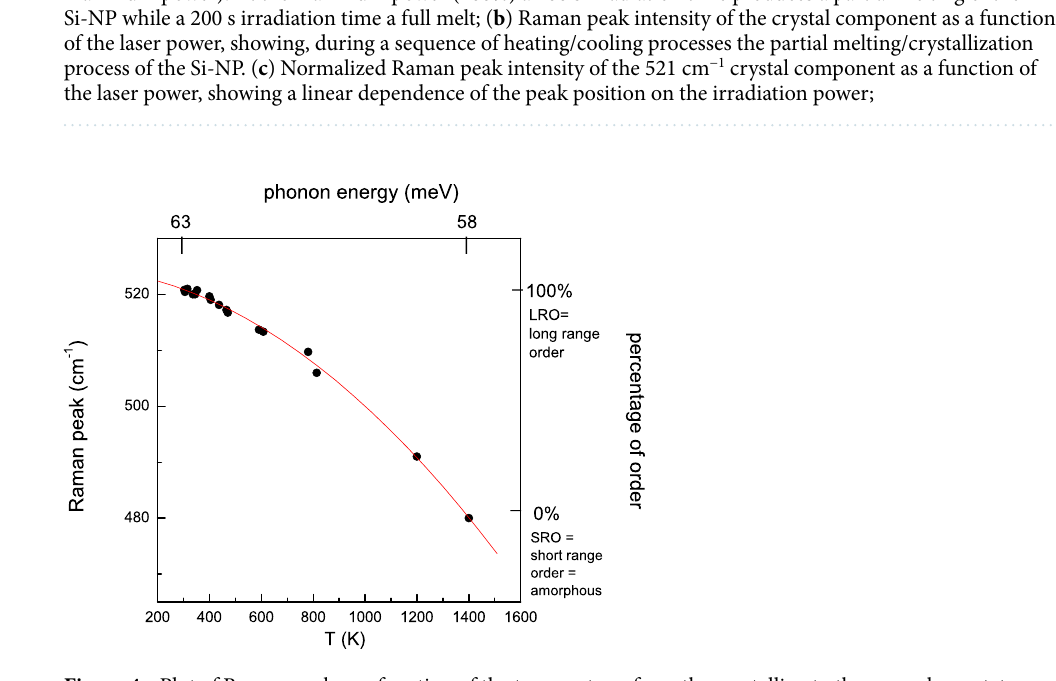
Figure 4. Plot of Raman peak as a function of the temperature, from the crystalline to the amorphous state. The phonon value at k = 0 is 63 meV, whereas it reduces to 58 meV for the amorphous configuration, where the values of k are averaged over the range permitted by the uncertainty principle. This is confirmed by the width at half maximum of the curves (not reported here) very wide for amorphous, whereas in crystals is very